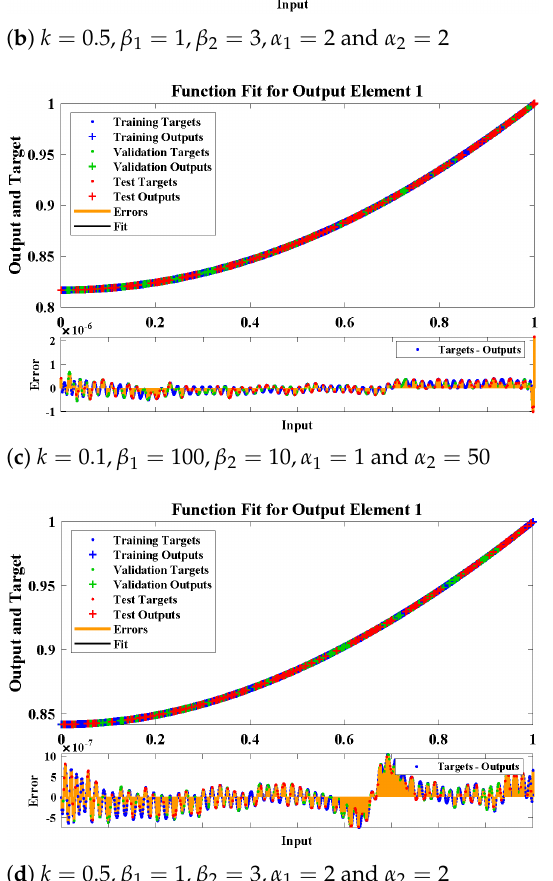
Figure 8. ( a , b ) The fitting of numerical solution with the results obtained by the NARX-LM algorithm for the concentration of CO 2 and ( c , d ) the concentration of